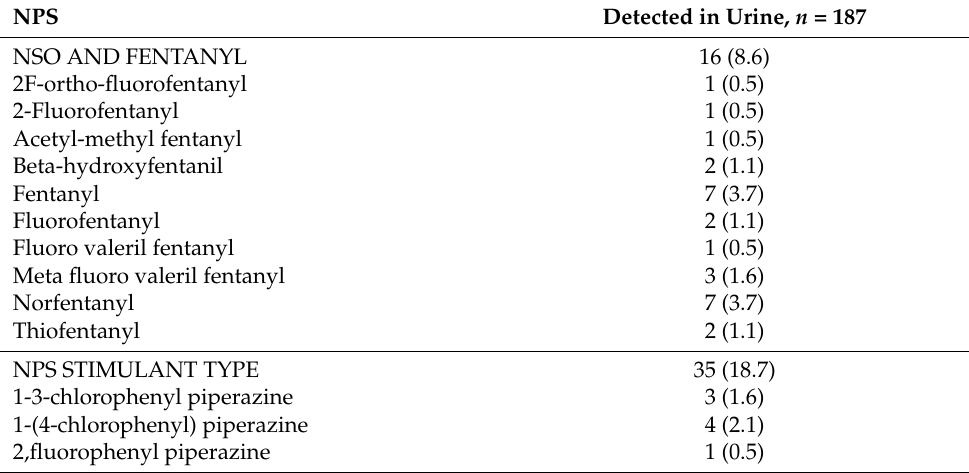
Table 1. Detected NPS and metabolites in biological samples (N =